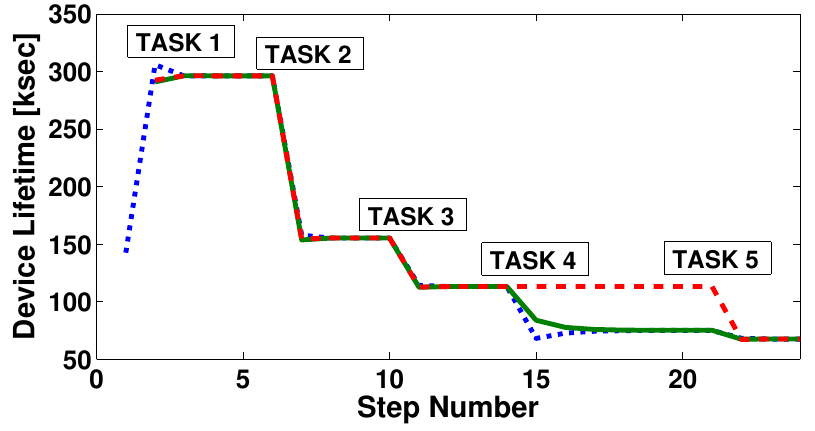
Figure 6. Example plot for algorithm